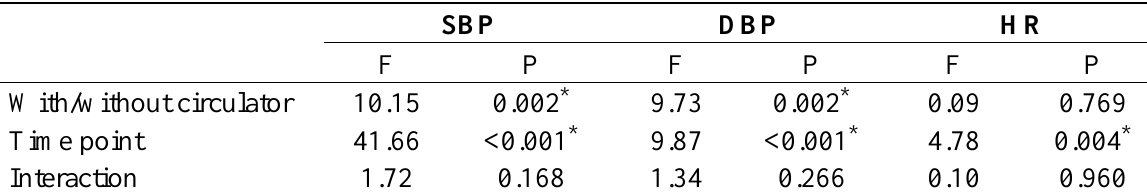
Table 2. The two-way (with/without circulator by time points) ANOVA